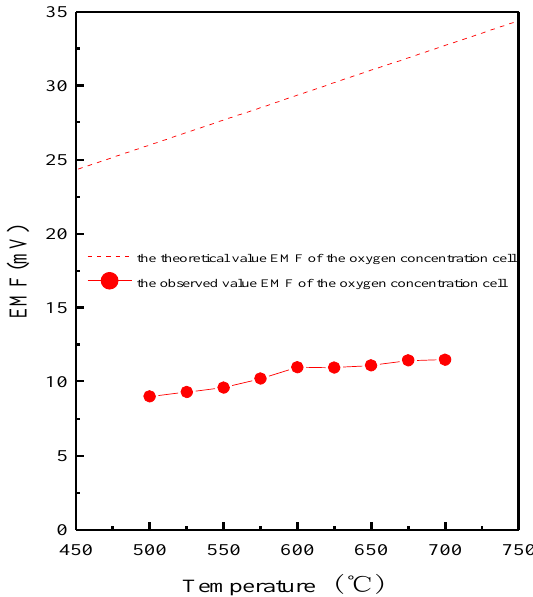
Figure 5. The electromotive force values of the oxygen concentration cell using SrCe 0.9 Sm 0.1 O 3-α (SCS) as electrolyte in the temperature range from 500 to 700 °C.